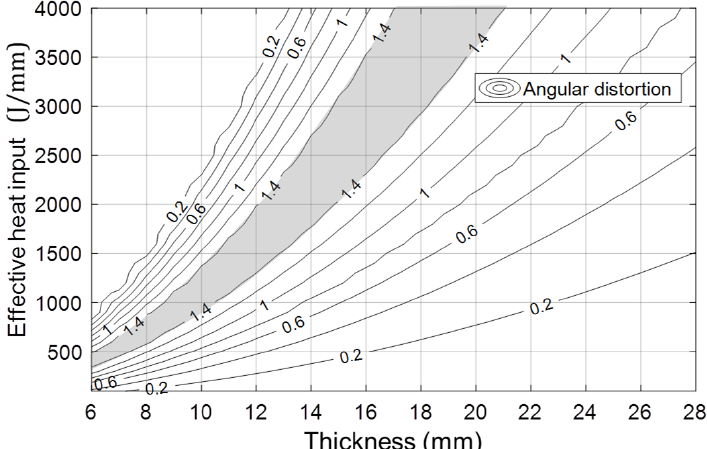
Figure 11. Contour of angular distortion with heat input and thickness; the gray zone shows the conditions for the maximum angular